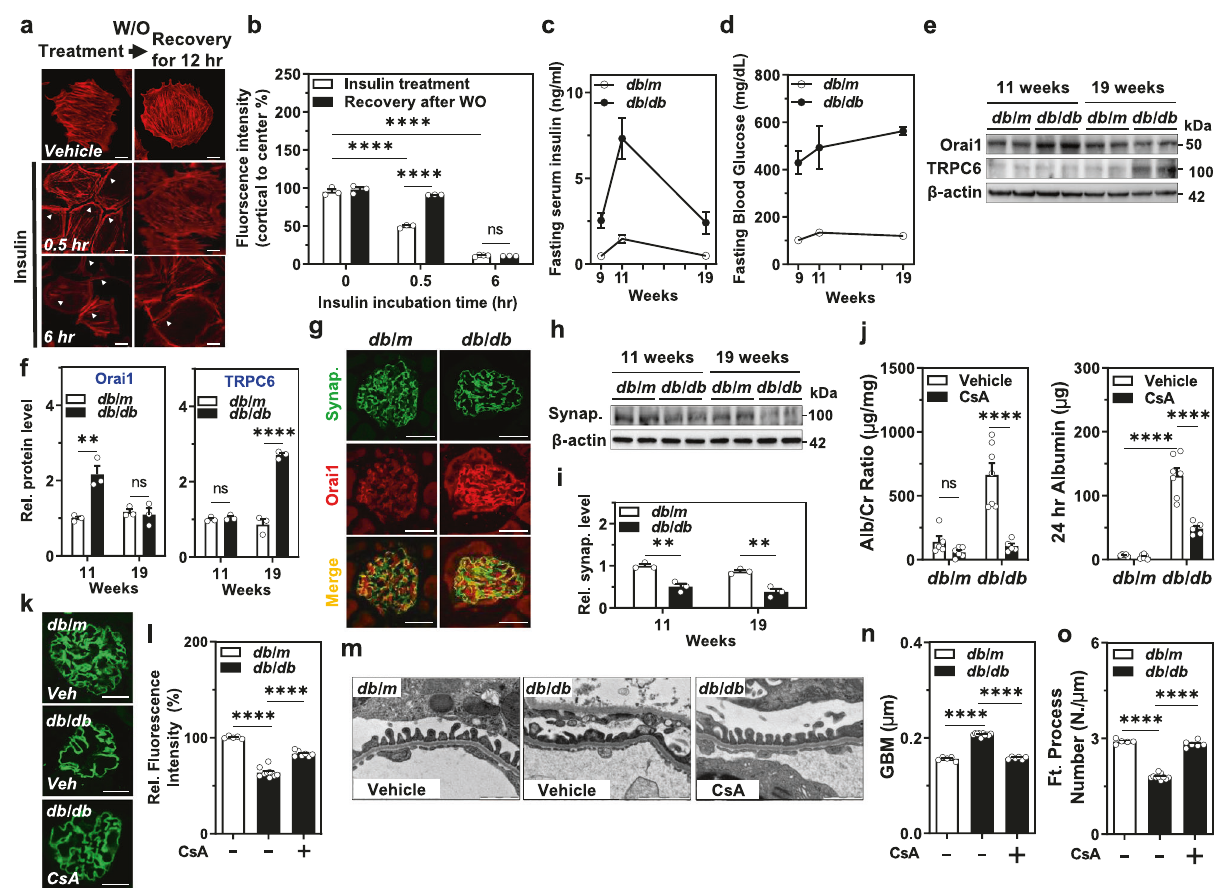
Fig. 5 Orai1 is overexpressed in hyperinsulinemic db/db mice and CsA ameliorates slit-diaphragm disruption and albuminuria. a Time-dependent recovery of insulin-mediated actin rearrangement. Podocytes were incubated with insulin for 30 min (short-term) or 6 h (long-term), washed out (W/O), and further incubated in an insulin-free medium for 12 h before phalloidin staining. White arrows indicate actin rearrangement by insulin treatment. Scale bar = 50 μ m. b Quanti fi cation of the actin fi ber intensity in a . n = 3, 3, 4, 5, 4, and 3 dishes, twenty images in each dish. c , d Analysis of the serum levels of insulin (ng/ml) ( c ) and glucose (mg/dL) ( d ) in db/m and db/db mice at 9, 11, and 19 weeks of age ( n = 5 mice each). e Representative immunoblotting showing Orai1 and TRPC6 expression in the glomerulus of db/m and db/db mice at 11 and 19 weeks. f Densitometry of Orai1 (left) and TRPC6 (right) in e . Relative (Rel.) protein levels were normalized to db/m mice (11 weeks of age) n = 3 independent experiments. g Representative immuno fl uorescence images of synaptopodin (synap.; green) and Orai1 (red) in the glomeruli of db/m and db/db mice. Immunostaining was repeated fi ve times independently from 5 mice each. Scale bar = 25 μ m. h Immunoblotting analysis showing synaptopodin expression in the glomeruli of db/m and db/db mice at 11 and 19 weeks. i Quanti fi cation of the western blots in h . n = 3 independent experiments. j Effect of cyclosporin A (CsA, i.p . injection) on urine Alb/Cr ratio (left) and 24 h urinary albumin excretion (right) in db/m and db/db mice ( n = 5 – 7 images from mice each). k Immuno fl uorescence staining showing the effect of CsA on synaptopodin dissolution in db/db mice. Scale bar = 25 μ m. l Summary of synaptopodin quanti fi cation in k . n = 30 images from 5 to 10 mice each. m Representative TEM images of foot processes from db/m and db/db mice with/without administration of CsA. Magni fi cation is ×30,000. Scale bar = 1 μ m. n , o GBM thickness ( n ) and an average number of foot processes per 1 μ m length of GBM ( o ) in db/m and db/db mice with/without administration of CsA. Thirty images from 5 – 7 mice in each group. Bar graph data are expressed as mean ± SEM and were analyzed using two-way ANOVA followed